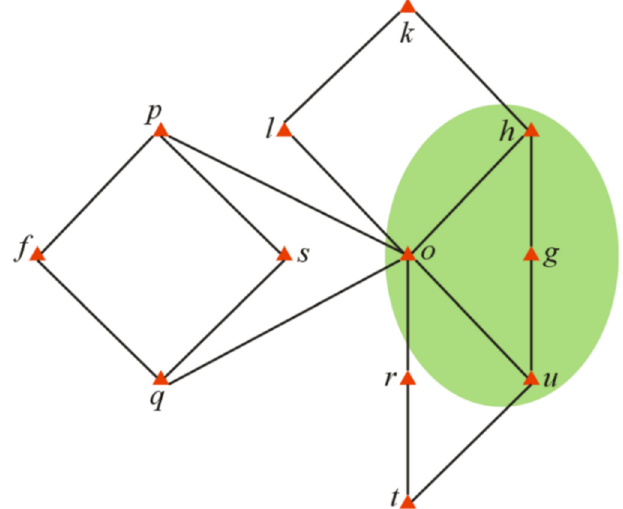
Figure 3. Hasse Diagram for set Ḝ .